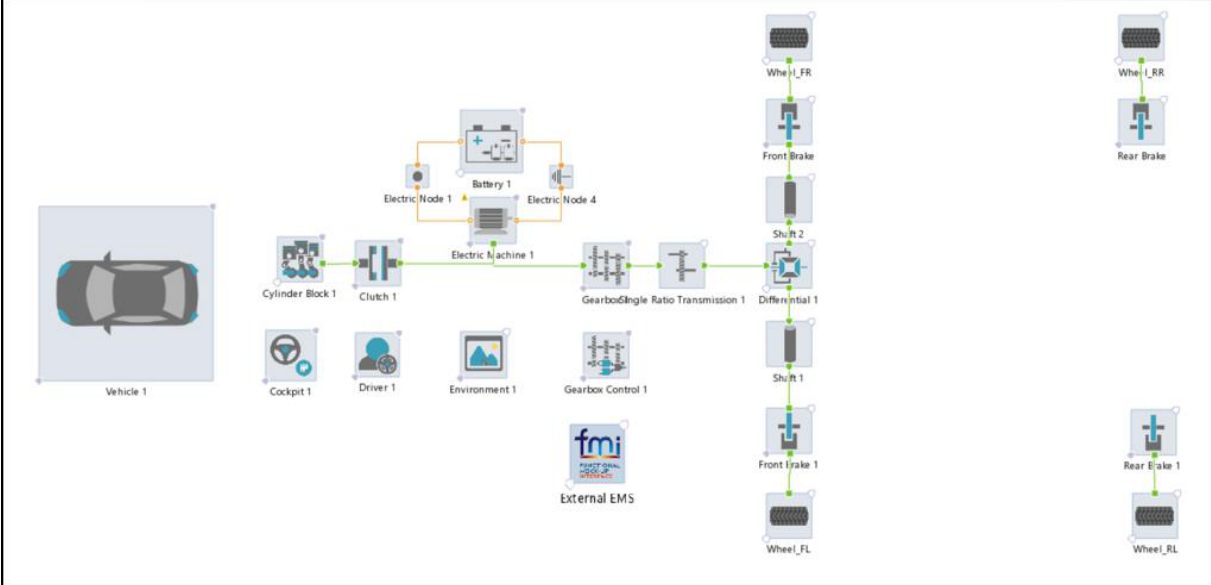
Figure 9. AVL CruiseM TM HEV model with parallel architecture and P2